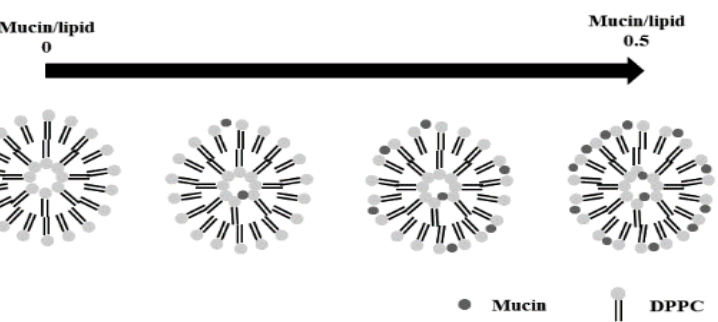
Figure 1. Schematic diagram of the vesicle structures with respect to the ratio of